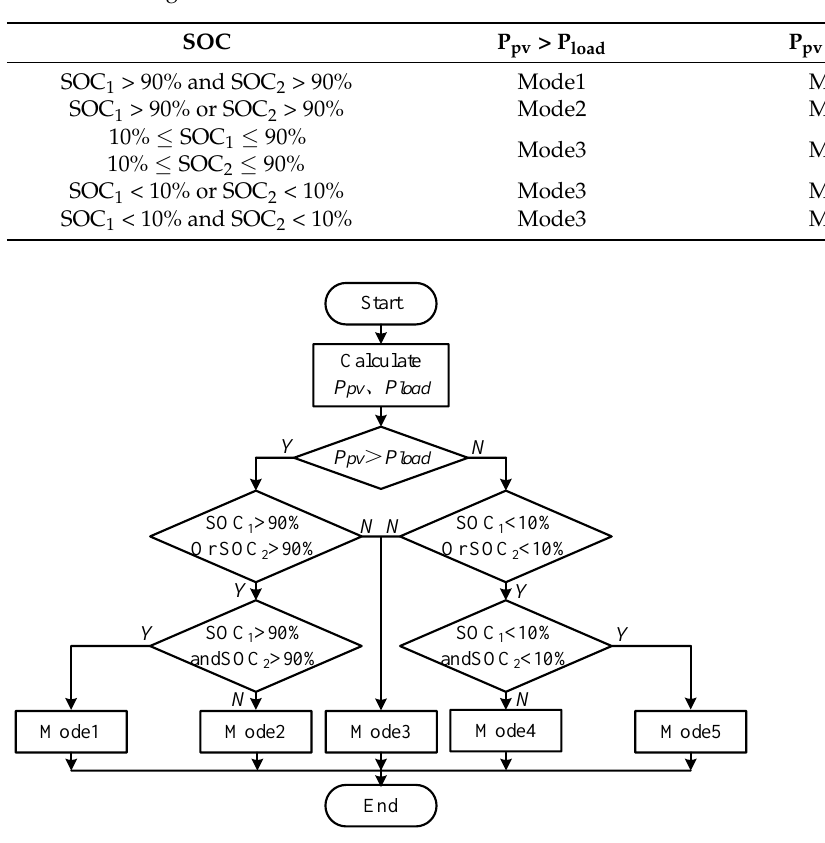
Figure 10. Control mode selection flow diagram.